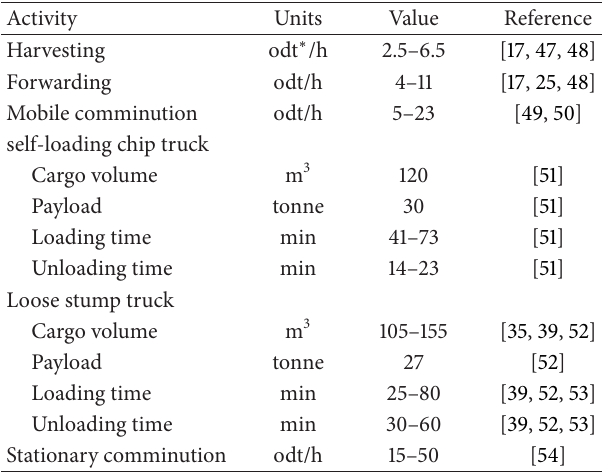
Table 1: Average/approximate data on various activities and speci- fications reported in the